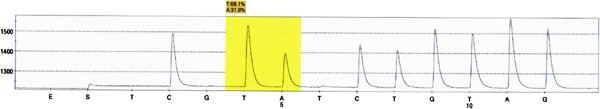
Pyrosequencing results demonstrate the presence of a 1799T>A mutation in codon 600 of the BRAF gene. The pyrogram shows a CAC>CTC change involving the second nucleotide position of codon 600, highlighted in yellow, in the reverse strand. Allele quantification reveals 68% mutant allele in the tumor sample. This nucleotide change results in a valine to glutamic acid substitution at amino acid position 600.